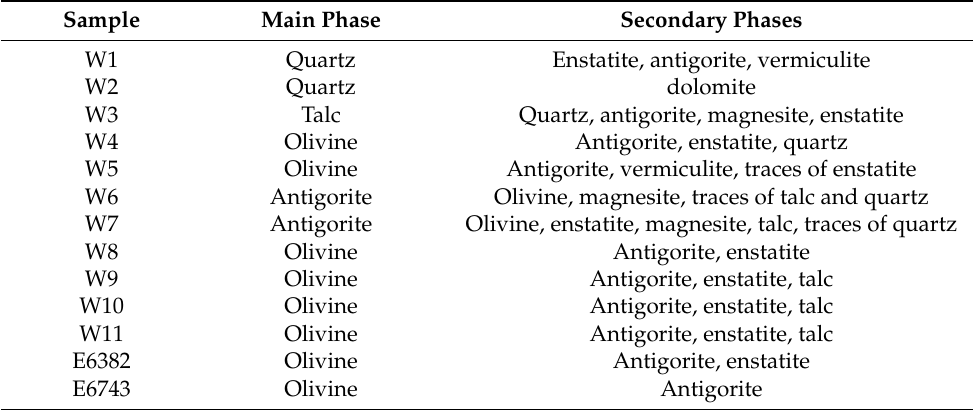
Table 2. Mineralogical analysis using X-ray Diffractometry